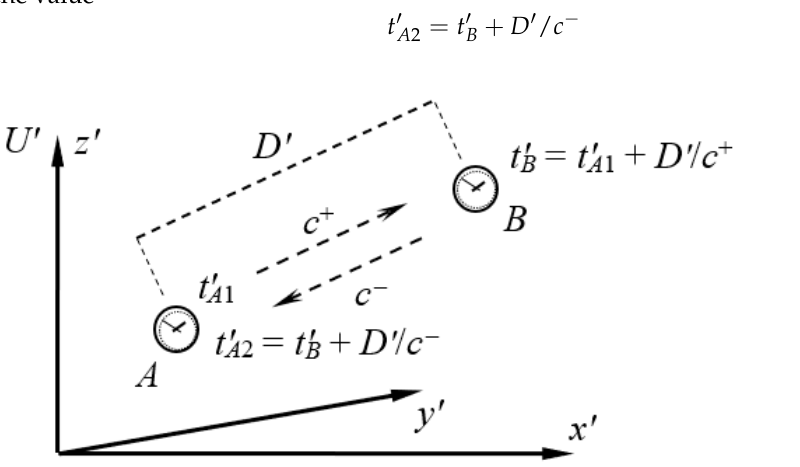
Figure 2. Synchronization of clocks with light means that time is measured by light clocks.